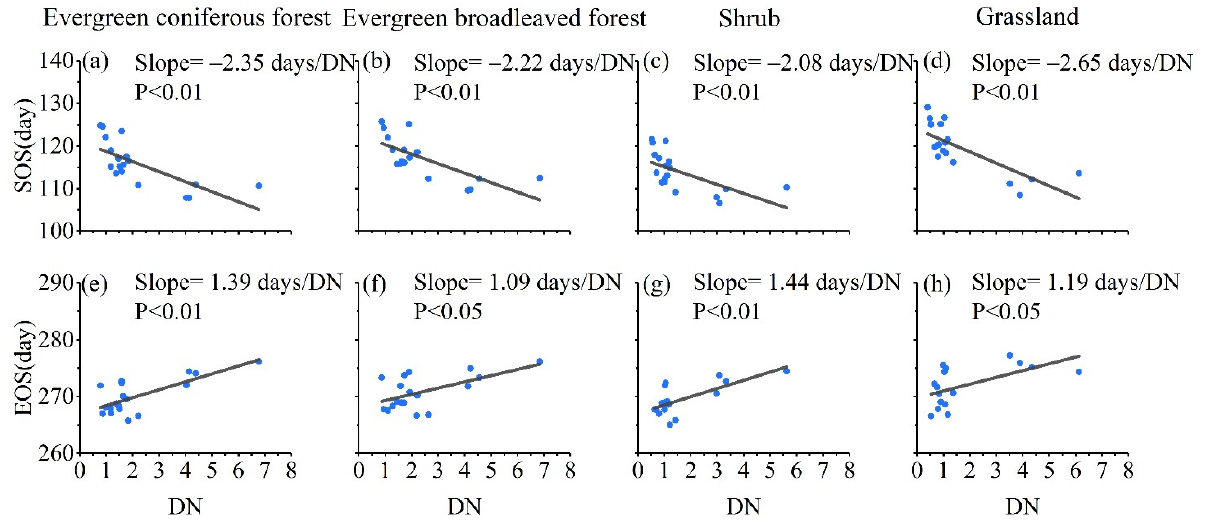
Figure 7. Sensitivity of vegetation phenology to light intensity in four vegetation types: ( a , e ) evergreen coniferous forest, ( b , f ) evergreen broadleaved forest, ( c , g ) shrub, ( d , h ) grassland. ( a – d ) start of the growing season (SOS) and ( e – h ) end of the growing season (EOS).